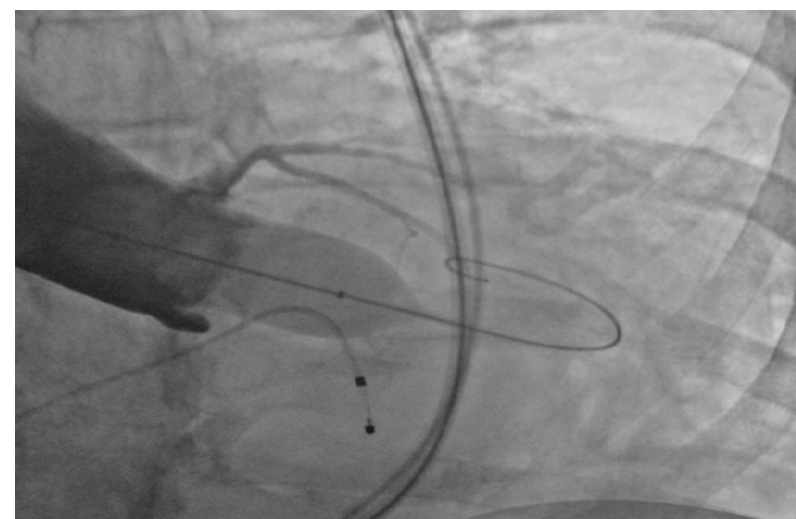
Figure 1. Balloon inflation across the aortic valve.